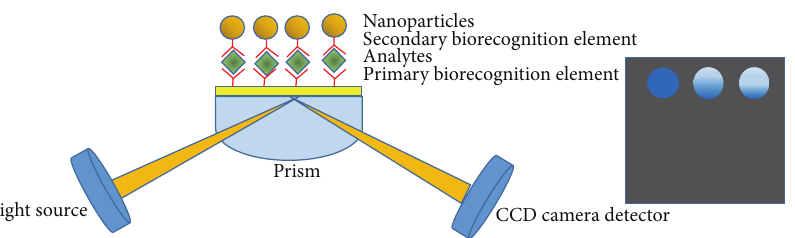
Figure 3: Scheme of SPR